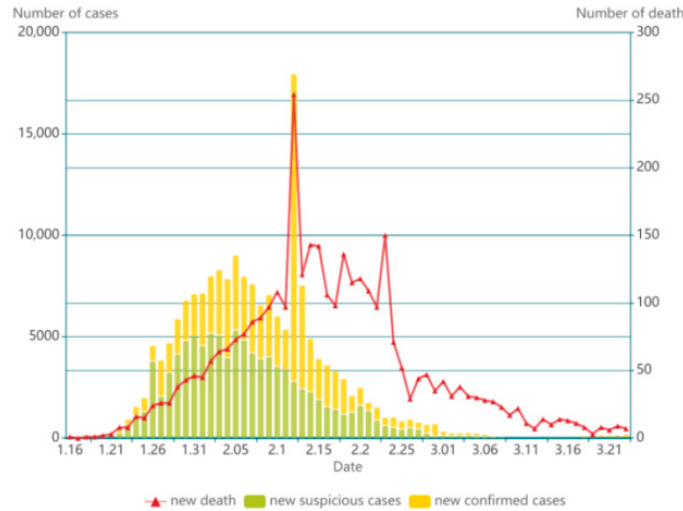
Figure 1. Epidemiological curve in China from 16 January to 21 March 2020.